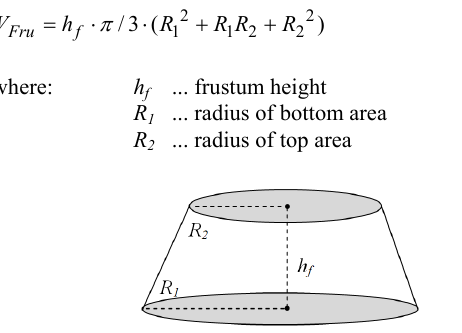
Figure 6. Frustum of a cone.